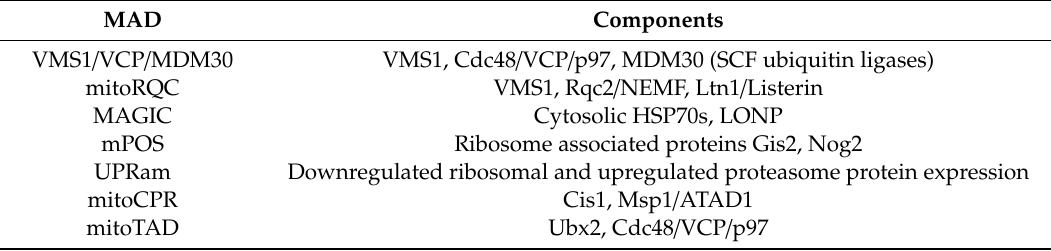
Table 2. Mitochondria associated degradation (MAD) or mitochondrial protein import associated degradationsystems. VMS1, VCPassociatedMitochondrialStress-responsive1; VCP,Velocin-containing protein; MDM30, Mitochondrial distribution and morphology protein 30; mitoRQC, Mitochondria associated ribosome quality control; MAGIC, mitochondria as guardian in cytosol; mPOS, mitochondrial precursor over-accumulation stress; UPRam, unfolded protein response activated by mistargeting of proteins; mitoCPR, mitochondrial Compromised Protein Import Response; mitoTAD, mitochondrial protein translocation-associated degradation; Cdc48, Cell division control protein 48; p97, 15S Mg(2 + )-ATPase p97 subunit; Rqc2, Ribosome quality control complex subunit 2; NEMF, Nuclear export mediator factor; Ltn1, E3 ubiquitin-protein ligase listerin; HSP70, Heat shock 70 kDa protein; LONP, Lon protease homolog; Gis2, GIg Suppressor 2; Nog2, Nucleolar GTP-binding protein 2; Cis1, CItrinin Sensitive knockout 1; Msp1, Mitochondrial Sorting of Protein 1; ATAD1, ATPase family AAA domain-containing protein 1; Ubx2, UBX domain-containing protein